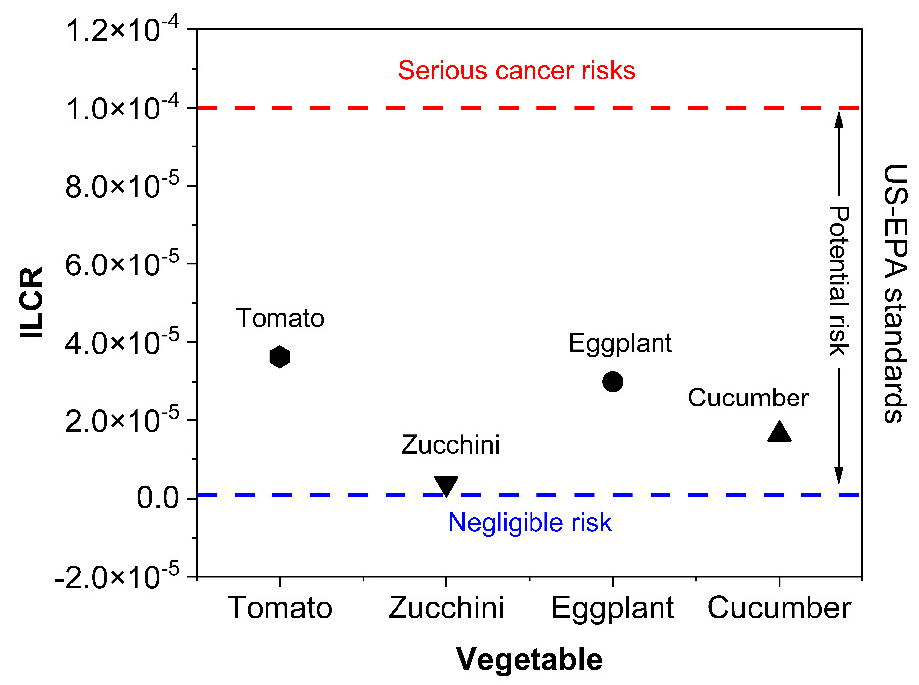
Figure 7. ILCR for PAHs in the different vegetables based on US-EPA standards.